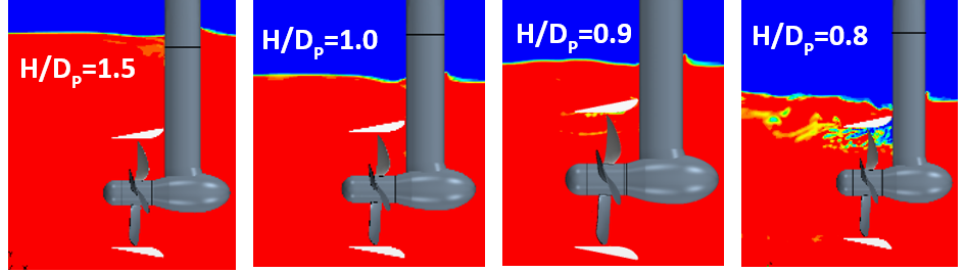
Figure 24. Ventilation inception with decrease in propulsor submergence, H/Dp, at J = 0.2.